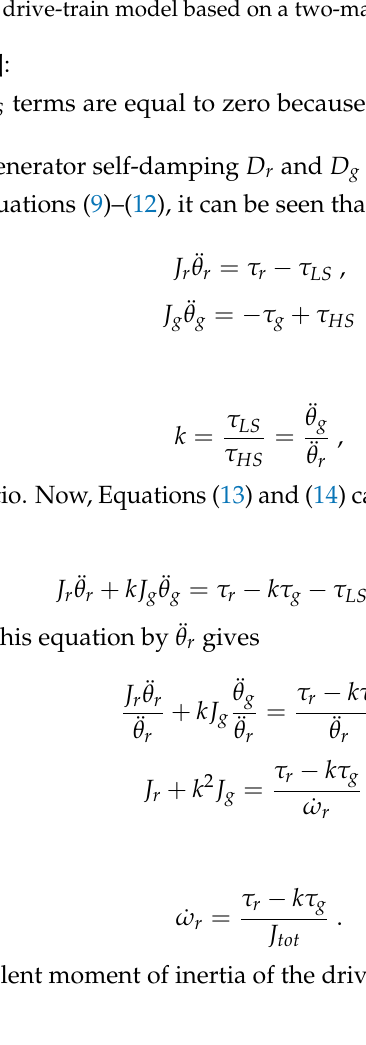
Figure 3. Wind turbine drive-train model based on a two-mass